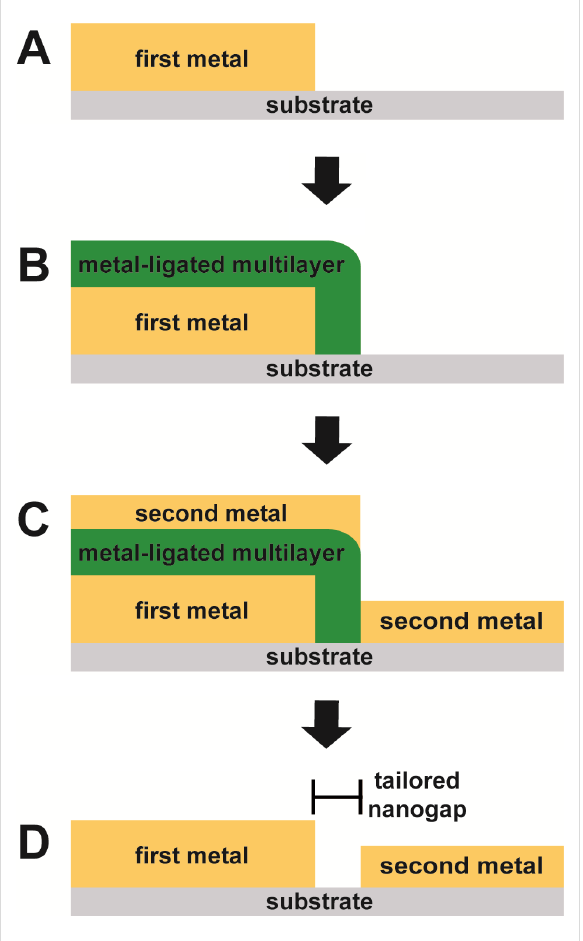
Figure 1: Key steps for the molecular-ruler process. (A) A metal is patterned on a substrate via conventional lithography. (B) A molecular- ruler, consisting of alternating layers of thiol molecules and metal ions, is created only on the first metal structure. (C) A second metal is deposited. (D) Upon removal of the molecular-ruler and the second metal on top of the multilayer via a chemical lift-off, a tailored nanogap is generated with a width that corresponds to the thickness of the